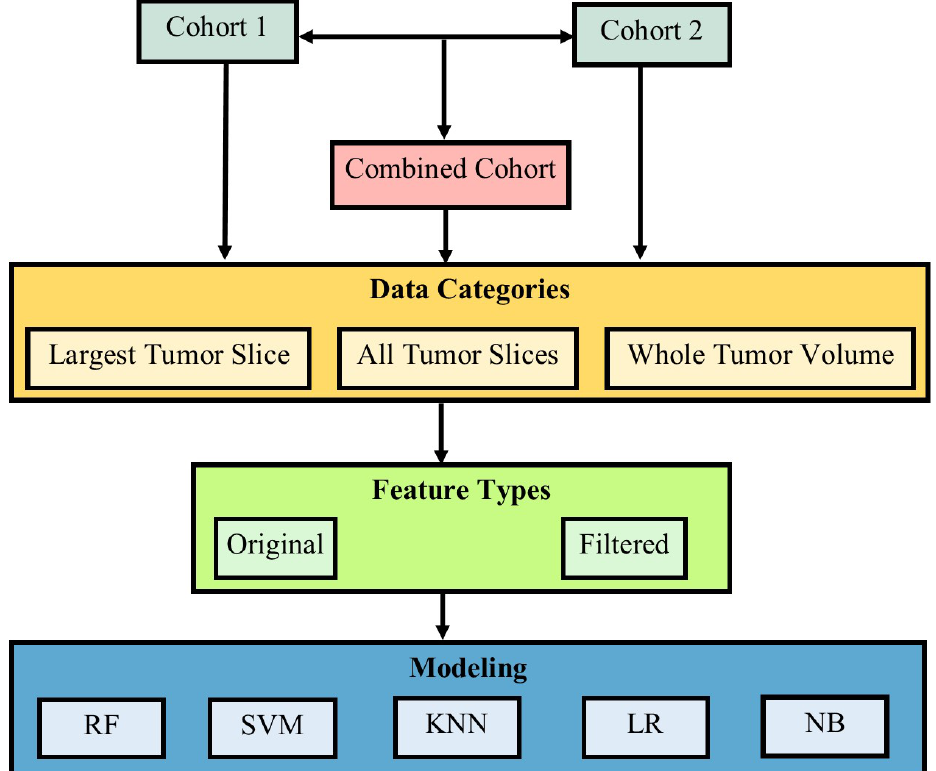
Figure 3. The diagrammatic representation of the strategies involved in the distinction of ChRCC from